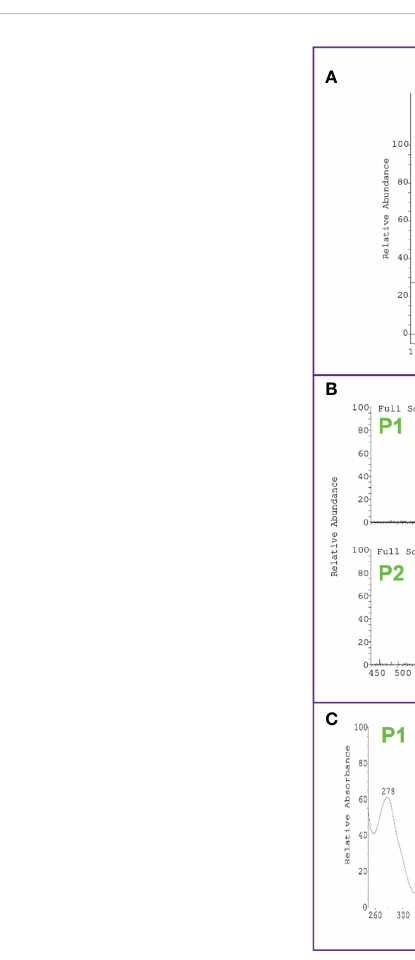
FIGURE 4 Identi fi cation of delphinidin-3- O -galactorhamnoside production in N. benthamiana leaves using Agrobacterium -mediated transient overexpression of VcMYBA1 + VcUFGT2 . (A) Chromatogram showing peak detection at 530 nm and earlier retention time of delphinidin-3- O -galactorhamnoside (P2) compared with delphinidin-3- O -rutinoside (P1) of VcMYBA1 + VcUFGT2 (bottom trace) in comparison to VcMYBA1 + VmANS as control (top trace). (B) Mass spectra of positive ion mode full scan MS, MS 2 and MS 3 fragmentation of the respective selected main ion, showing loss of rhamnose and hexose in MS 2 and fragmentation of the delphinidin aglycone in MS 3 . Molecular weight and fragmentation spectra are identical for P1 and P2, indicating that both anthocyanins have the same chemical formula and are therefore stereoisomers. (C) Full UV-Vis spectral scan, showing typical absorption spectrum of delphinidin for both